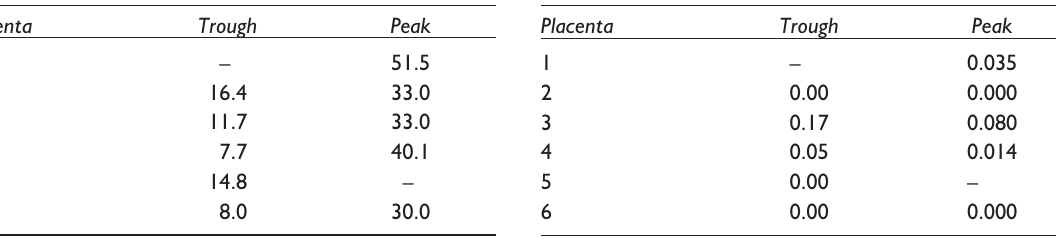
Table 2 Mean vancomycin clearance indexes,